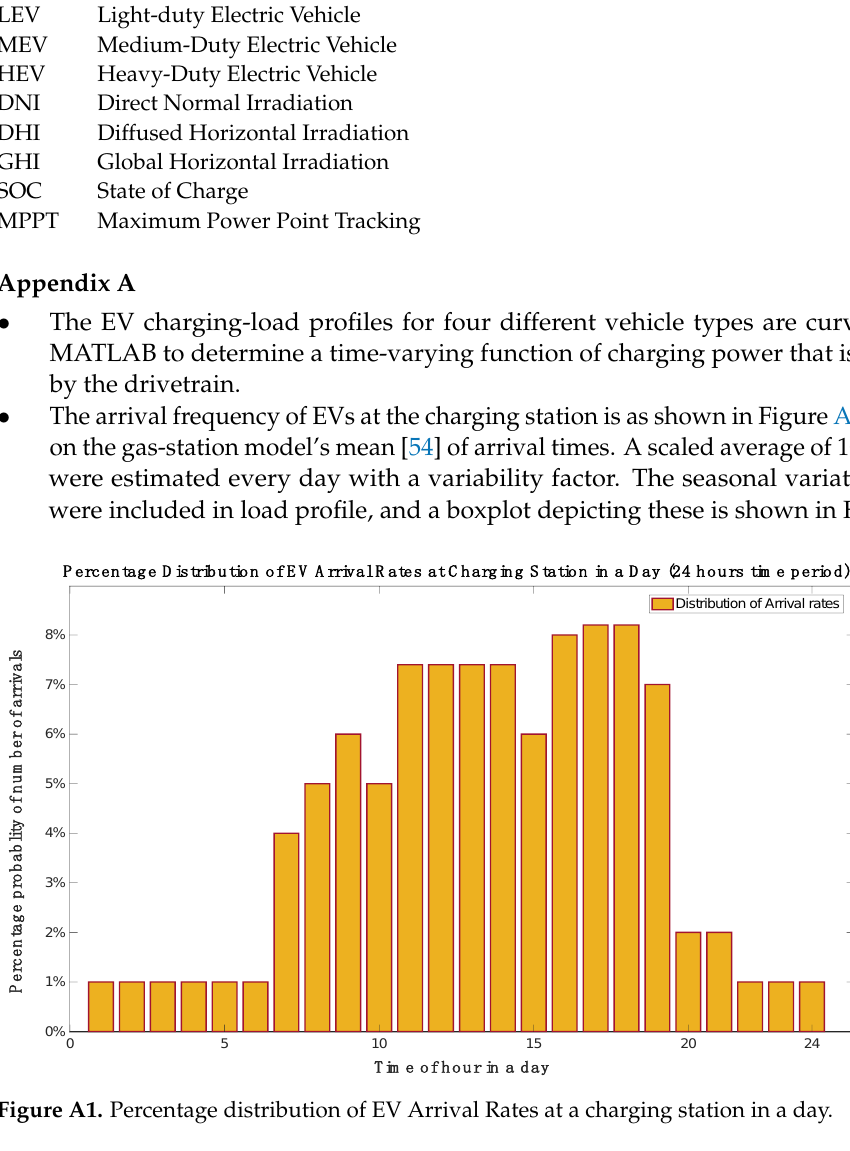
Figure A2. Charging profile with seasonal variations with different months of the year. Appendix B The system loss percentages for AC transmission and distribution from PV farm gen- eration to XFC EV charging station loads are calculated as follows: • PV-inverter loss: Inverters either in central or string arrangements of PV panels in the farm have improved efficiencies in the range of 94 – 98% [84,85] for various rated load- ing factors. However, at utility-scale PV farms, inverter clipping losses and DC/AC